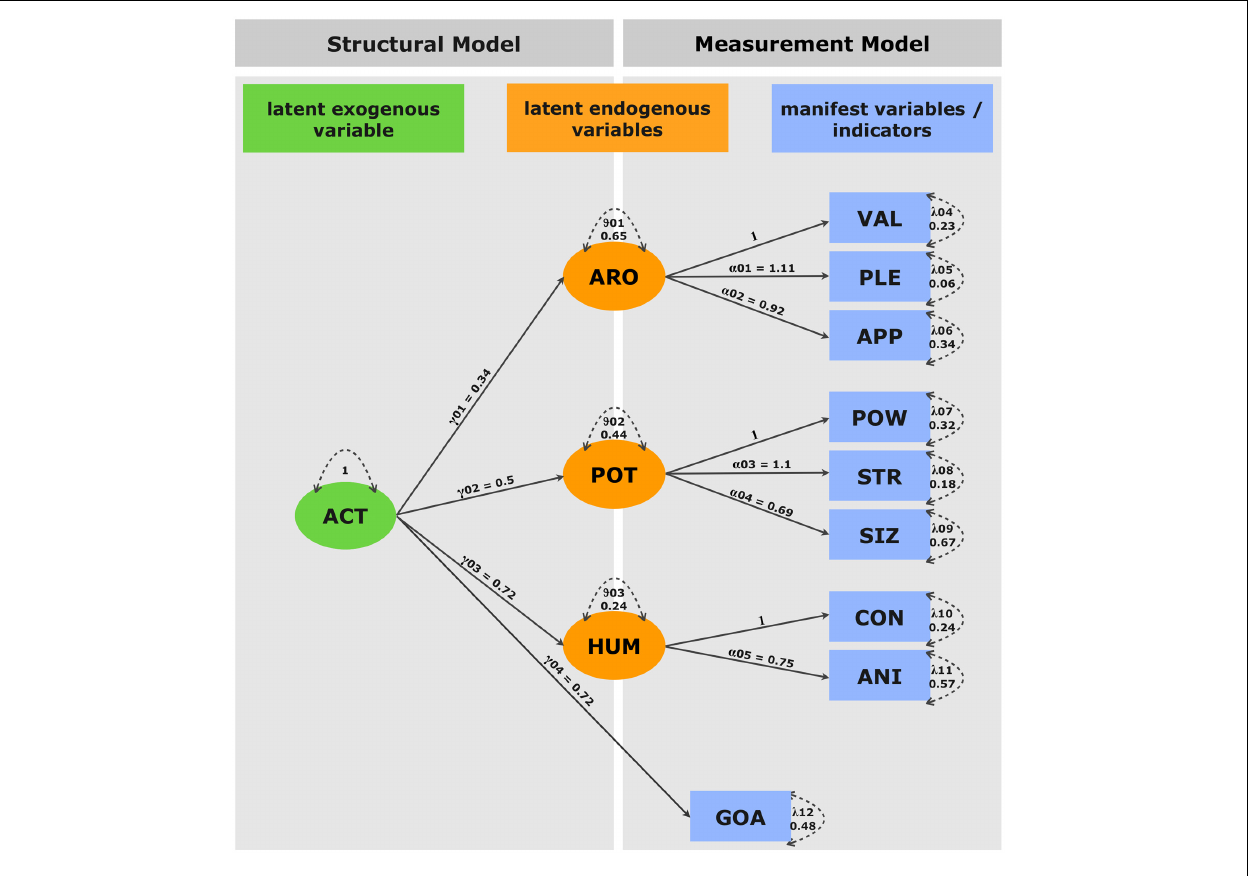
causally dependent upon the exogenous variable (ACT). Alpha 01–05 represent the causal dependency of manifest variables VAL, PLE, and APP on EVA; POW, STR, and SIZ on POT as well as CON and ANI on HUM. Error variance is represented by delta 1–12 (dashed double-headed